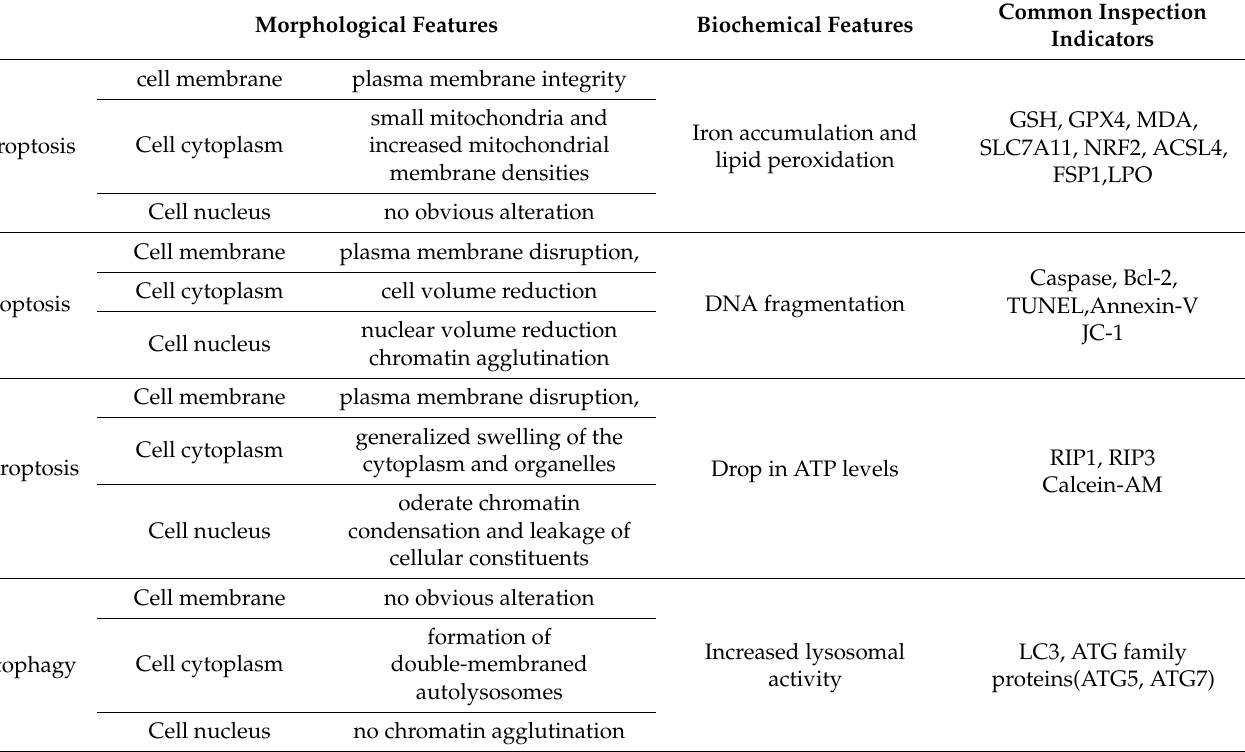
Table 1. The features of different forms of